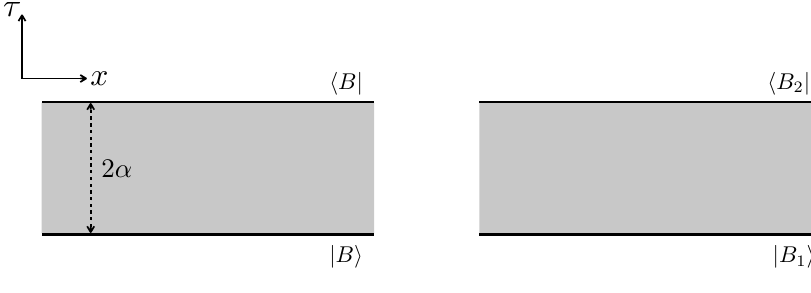
Figure 28 . The Euclidean path integral setup corresponding to a density matrix after a global quench (left) and that corresponding to the transition matrix (7.6) (right),